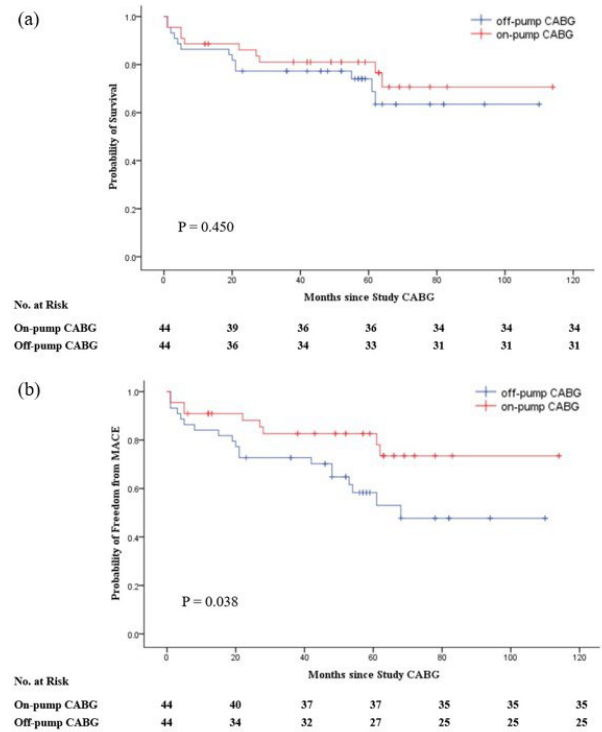
Figure 2. Kaplan–Meier estimates of rates of survival ( a ) and major adverse cardiovascular events (MACE) ( b ) after matched. Survival calculations were based on deaths from any cause. The composite MACE outcome was defined as death from any cause, nonfatal myocardial infarction, or repeat revascularization (CABG or